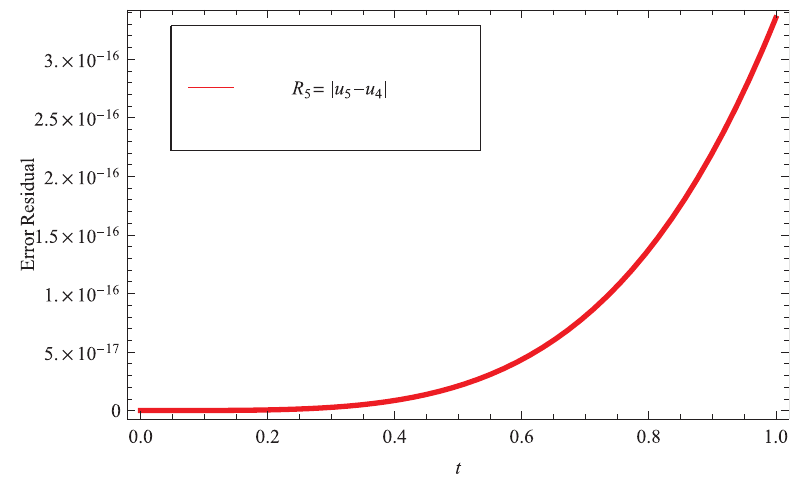
Figure 7. Plot of residual error R 5 = | u 5 − u 4 | by HATM.